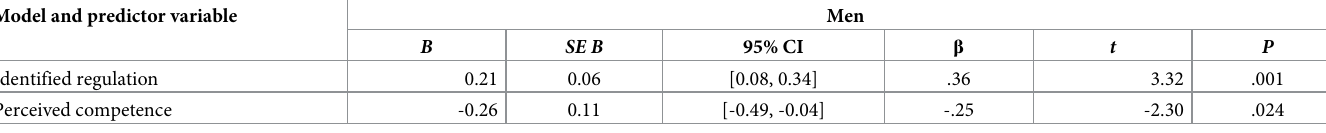
Table 3. Regression analysis for men students’ amotivation variations, predicted by behavioural regulations and psychological needs satisfaction. Model and predictor variable Identified regulation Perceived competence CI = confidence interval for B . Models based on backward deletion